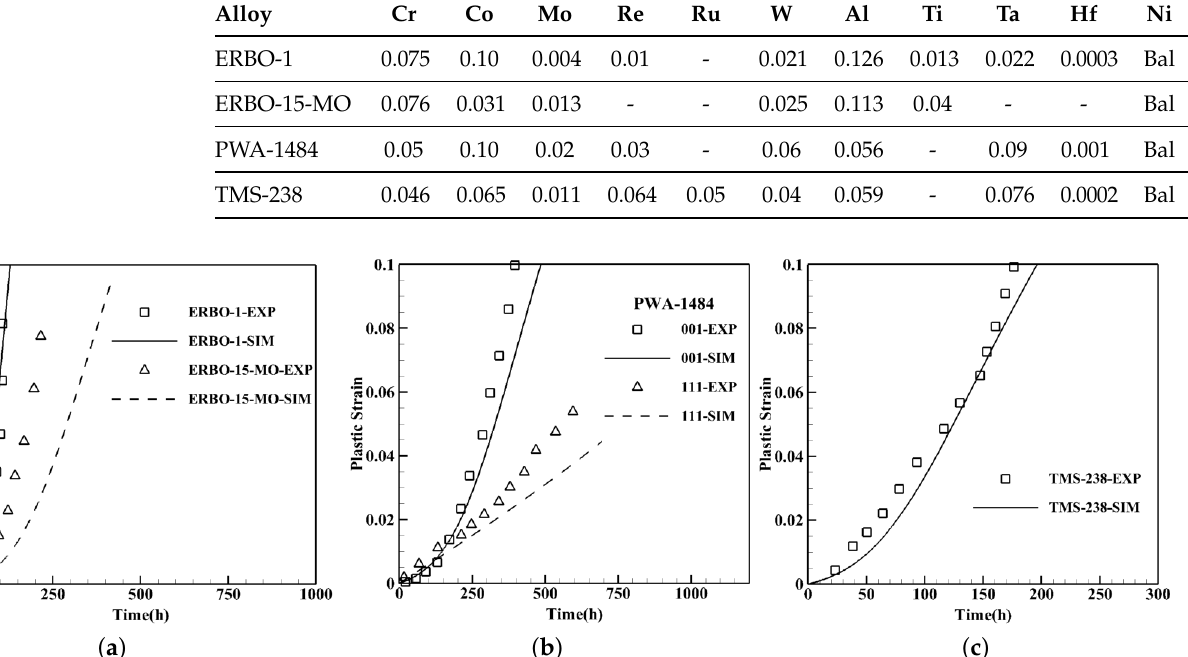
Figure 6. Creep curves for single-crystal nickel-base superalloys with different compositions com- pared to the experimental data. ( a ) ERBO-1 and ERBO-15-MO [38] under 160 MPa at 1050 ◦ C. ( b ) PWA-1484 [39] under 345 MPa at 927 ◦ C. ( c ) TMS-238 [41] under 735 MPa at 800 ◦